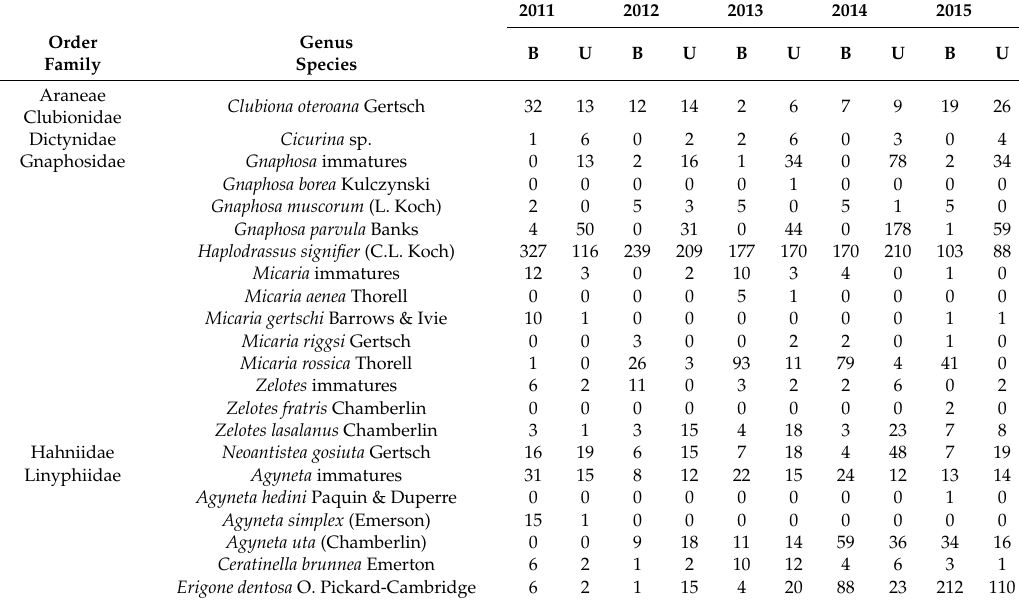
Table A3. Species and numbers collected for Mountain Valley Grassland at Valles Caldera National Preserve 2011–2015. B = burned sites, U = unburned sites. Undet. = undetermined